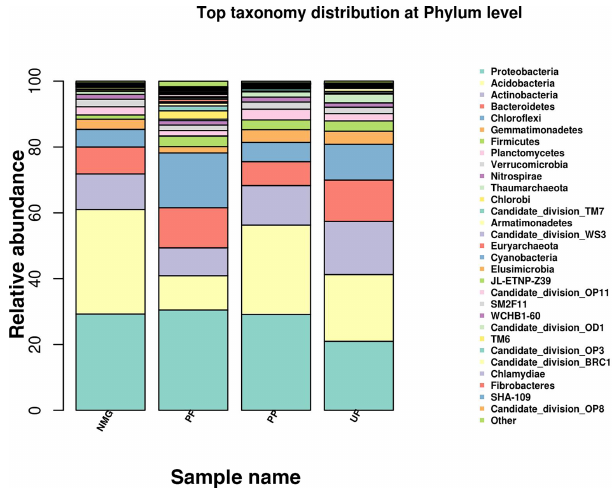
Figure 2. Top taxonomic distribution of soil samples at phylum level. NMG: native meadow grassland; UF: 50-year upland field; PF: 26-year paddy field; PP: 34-year poplar